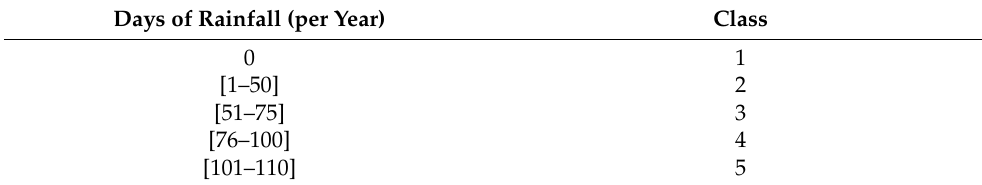
Table 4. Class division for days of rainfall in a year (DR), depending on the hours of sunshine per year for each